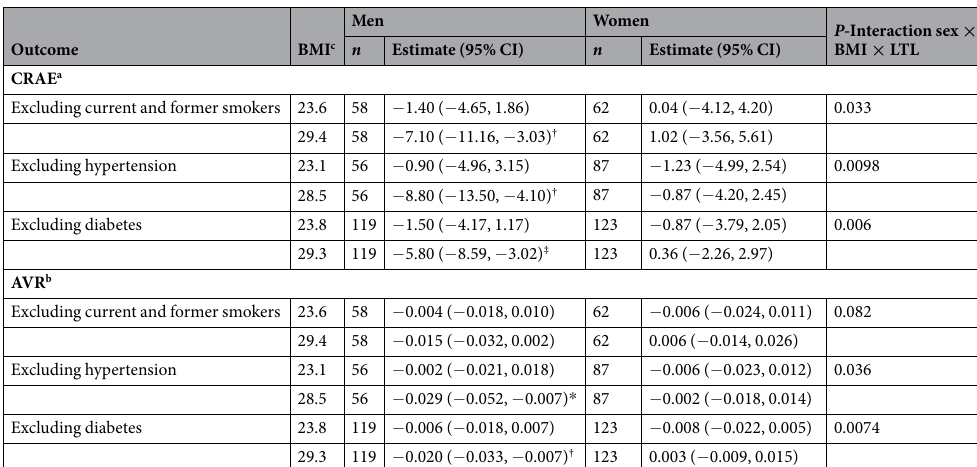
Table 3. Sensitivity analyses for the association of CRAE and AVR with leukocyte telomere length, stratified by sex and BMI. Abbreviations: BMI, body mass index; CI, confidence interval; LTL, leukocyte telomere length; CRAE, central retinal arteriolar equivalent; AVR, arteriole-to-venule ratio. Models adjusted for age, sex, systolic blood pressure, smoking status, BMI as fixed effects and adjusted for participants nested within a family cluster as random effect. a Estimates presented as difference in arteriolar diameter ( μ m) for a 20% shorter LTL; b Estimates presented as difference in arteriole–to–venule ratio for a 20% shorter LTL; c BMI in kg/m 2 provided for the 25th and 75th percentile. Significance for estimates: * P ≤ 0.05, † P ≤ 0.01, ‡ P <